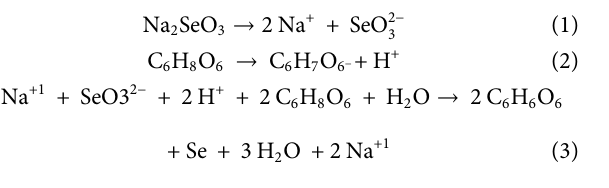
Frontiers in Environmental Science |